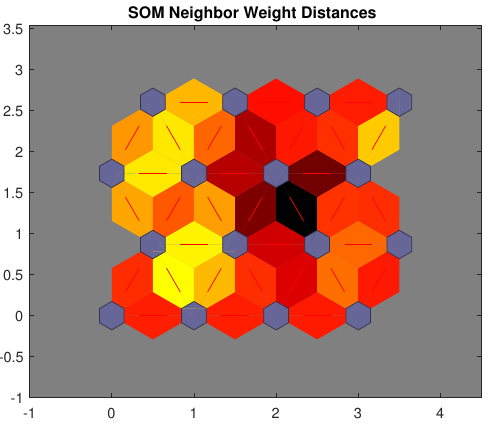
Figure 10. Self Organizing Map (SOM) neighbor distances.